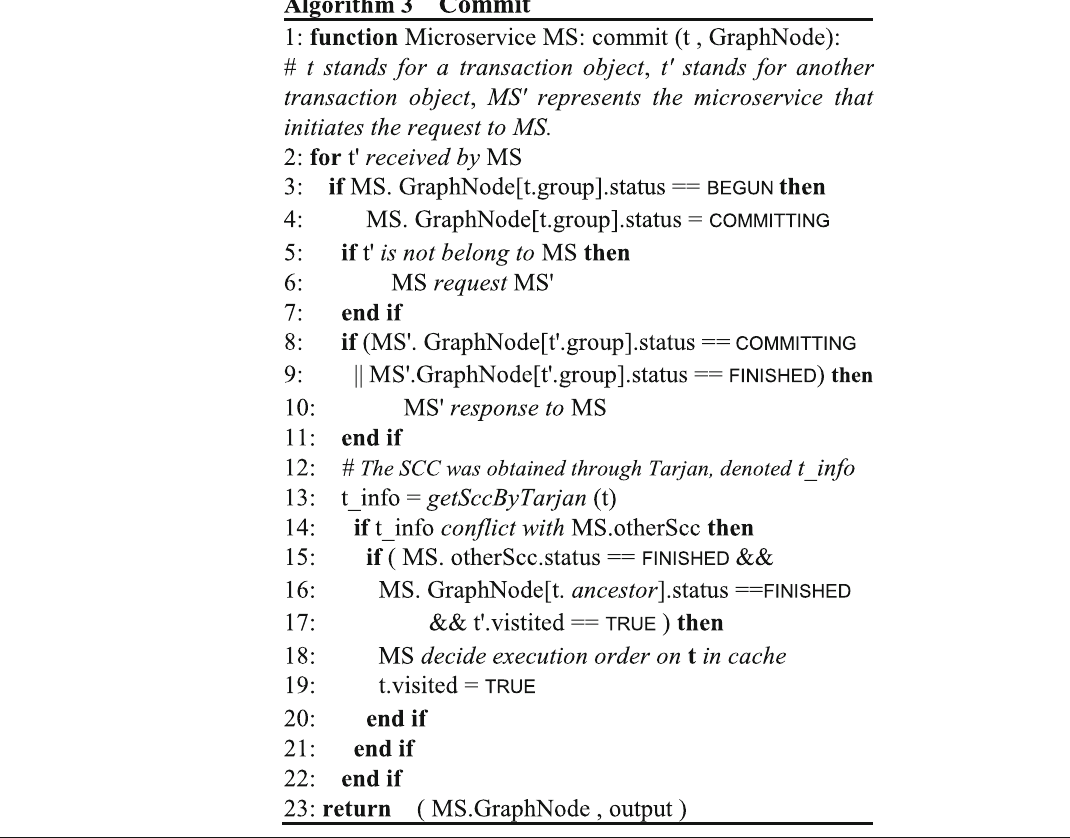
Table 4 Algorithm implementation of Commit phase